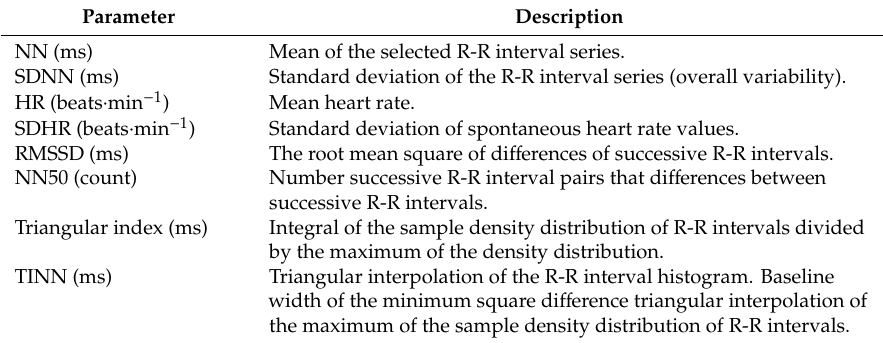
Table A1. Description of time-domain HRV measurements.